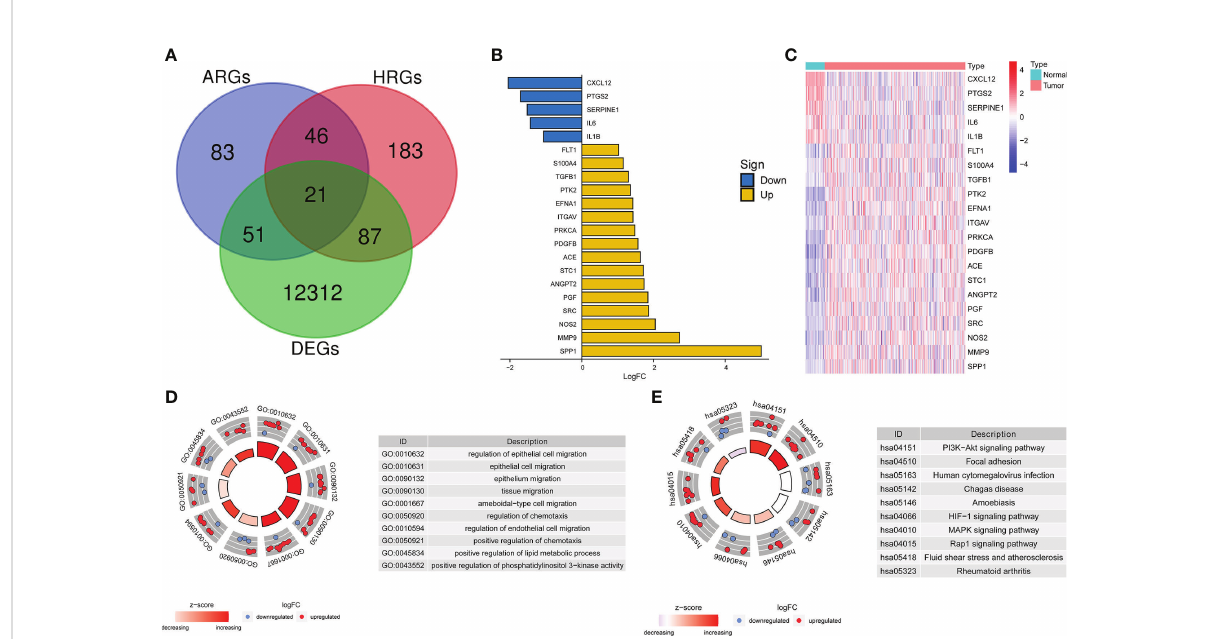
FIGURE 2 Screening and enrichment analysis of hypoxia-related angiogenesis genes. (A) Venn diagram of 21 differentially expressed HRAGs in the TCGA cohort. (B) Deviation plot and (C) heatmap of 21 differentially expressed HRAGs in HCC and noncancerous tissues. (D) GO (E) and KEGG analyses revealed the most signi fi cantly enriched biological functions and pathways of the overlapping differentially expressed